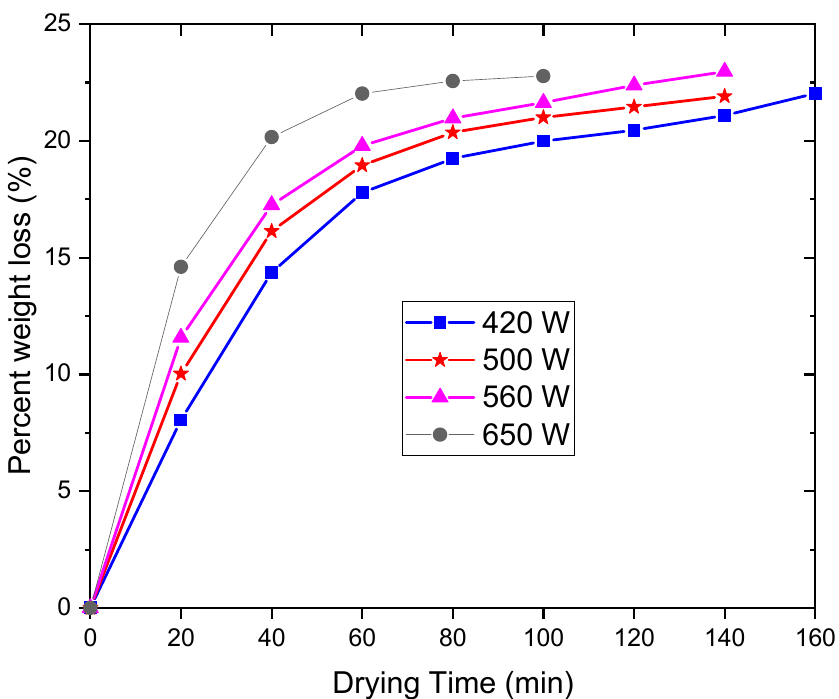
Figure 7. The relationship between drying times and percent weight loss of the STR5L samples when different microwave power levels were applied.